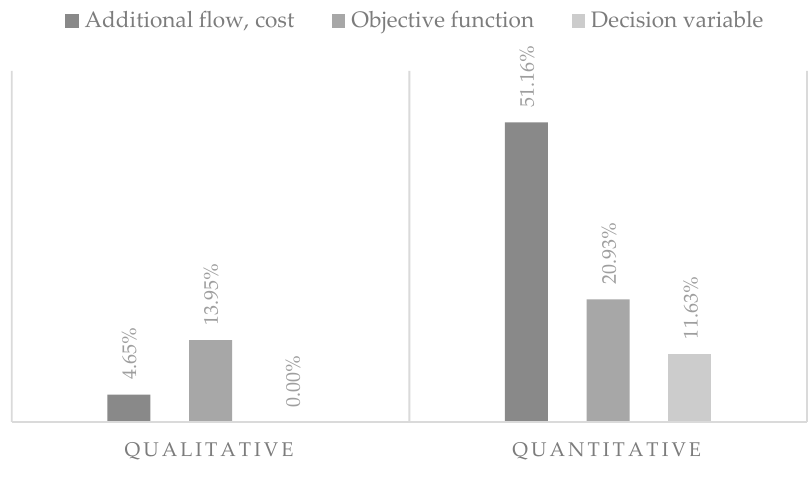
Figure 7. Classification output.